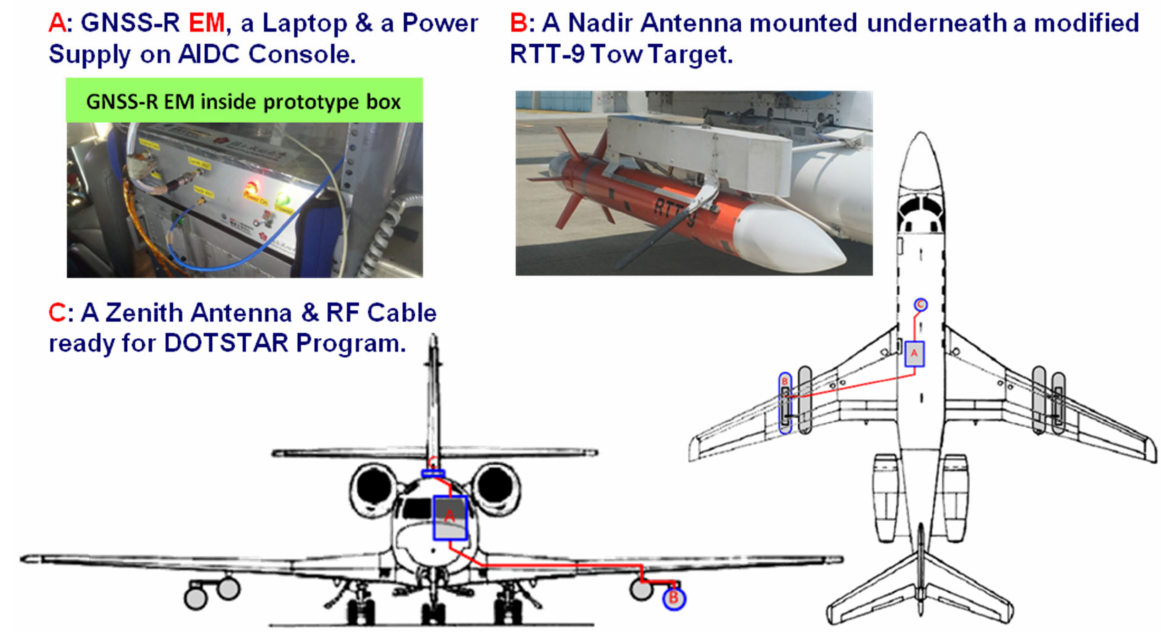
Figure 13. An Aerospace Industrial Development Corporation (AIDC) flight test with GNSS-R EM.